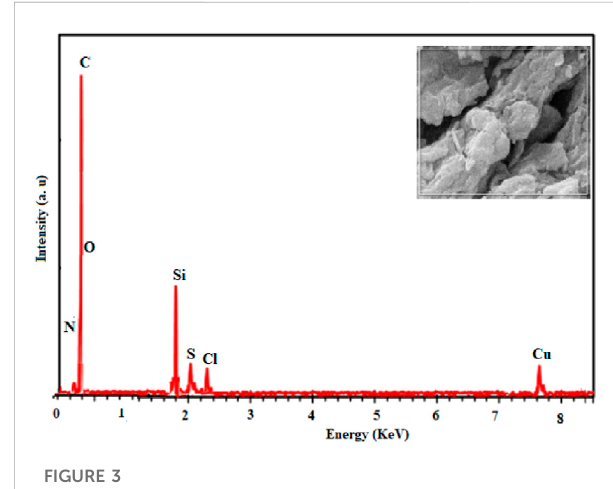
FIGURE 3 EDX analysis of Cu-PTC@GO.